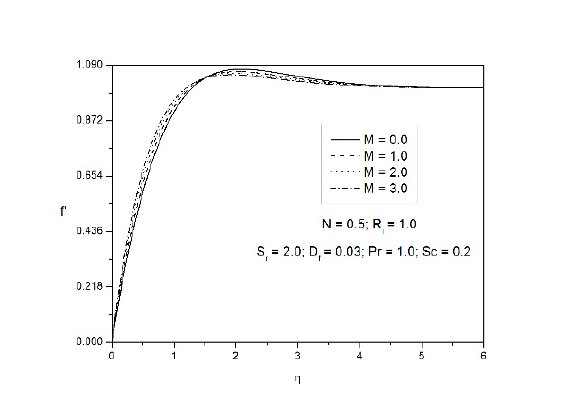
Figure 1. Velocity profile for various values of Magnetic parameter M